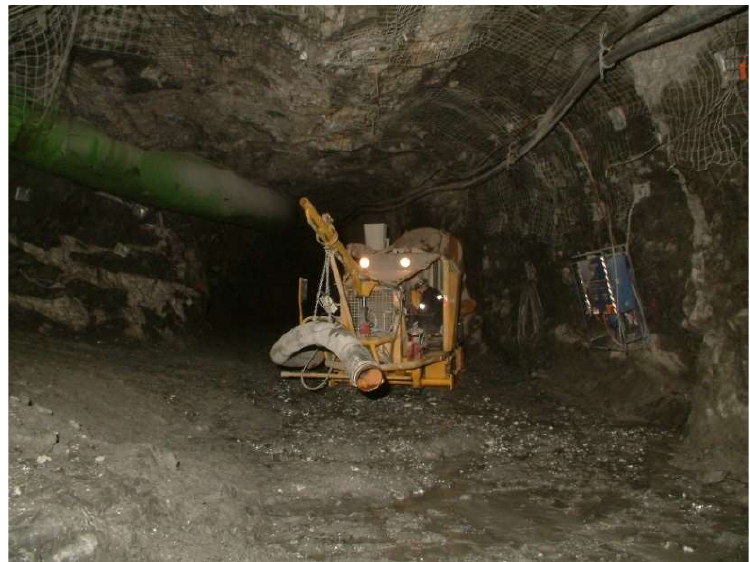
Figure 6. Ausvac Supersucker unit underground in an ore drive. The accumulation of broken ore residues on the drive floor in front of the Supersucker is clear.